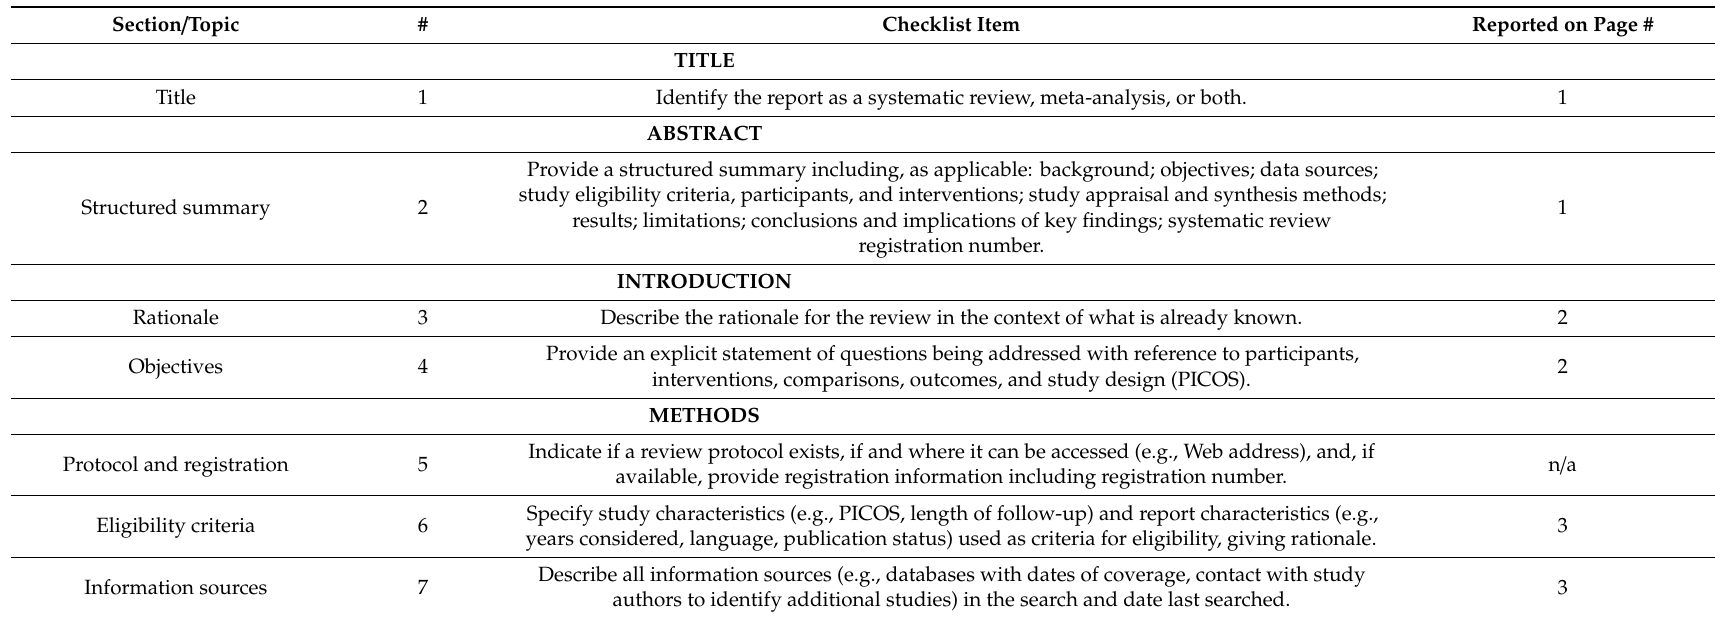
Table A2. The PRISMA checklist outlining the approach implemented within this systematic review